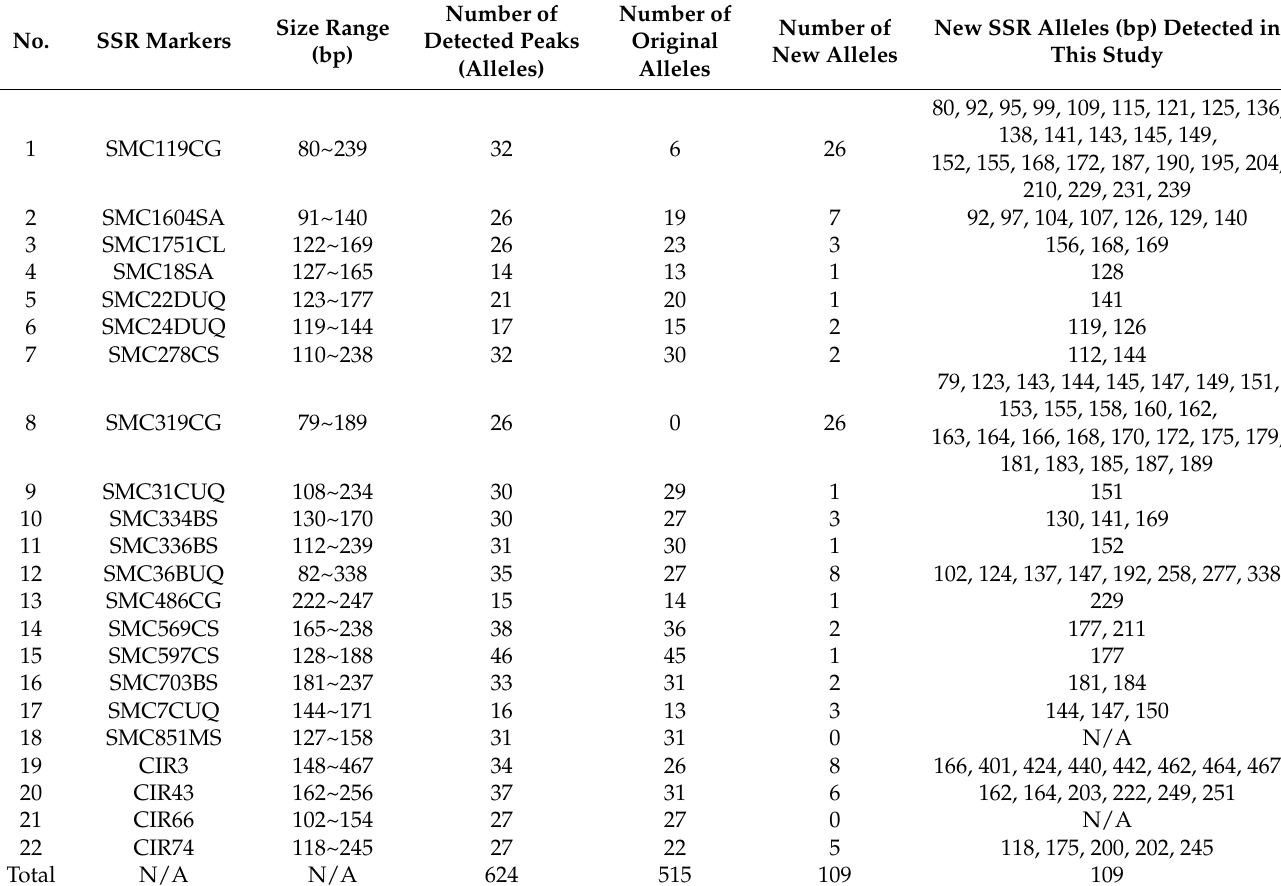
Table 1. The general utility and amplification profile of 22 pairs of fluorescence-labeled SSR primers based on a capillary electrophoresis (CE) detection